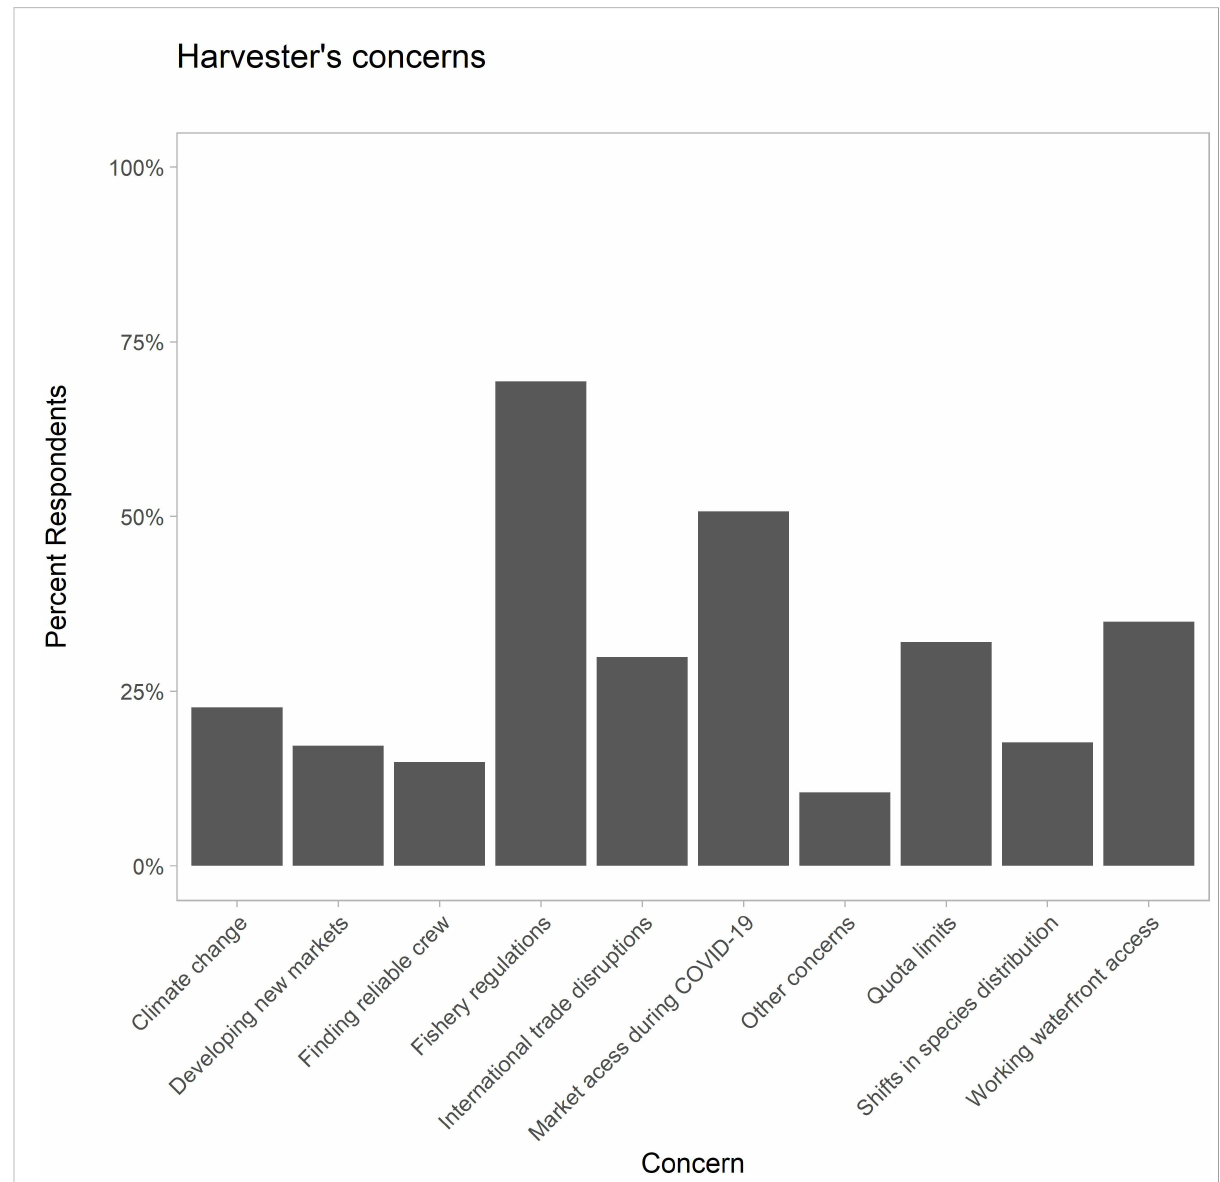
FIGURE 3 Harvester perceptions regarding the main concerns affecting their fi shing business. Respondents were given the opportunity to indicate their top concerns regarding fi shing businesses and were able to select 3 of the 10 options